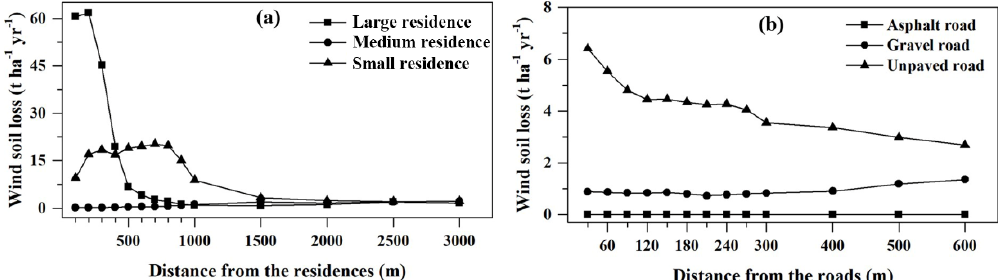
Figure 6. Variation in wind soil loss in the buffer zones for different sizes of residences (a) and types of roads (b). Note: large, medium, and small residences are divided according to size, corresponding to more than 4000 m 2 , 1000–4000 m 2 , and less than 1000 m 2 respectively.